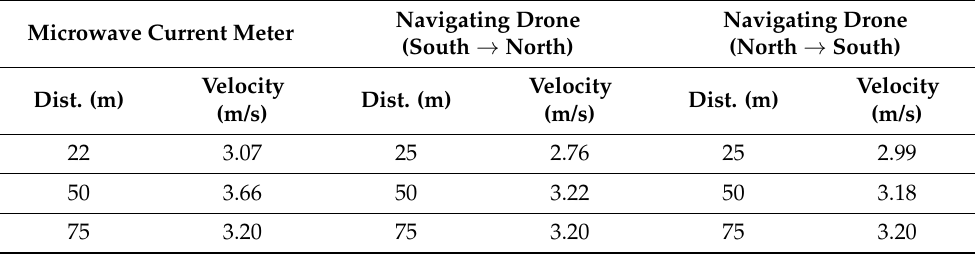
Table 2. Comparison of velocities